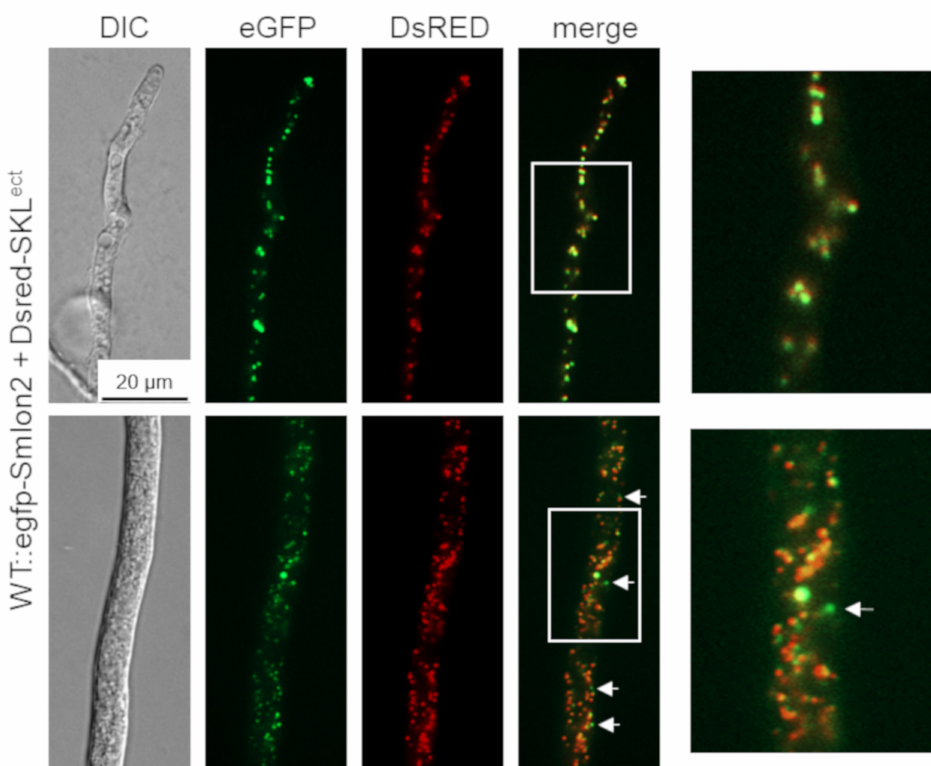
Figure 2. Co-localization of SmLON2 and the glyoxysomal reporter protein DsRED-SKL. Fluorescence microscopy was performed with the S. macrospora WT strain expressing eGFP-SmLON2 and the glyoxysomal reporter protein DsRED- SKL (WT::egfp-Smlon2 + Dsred-SKL ect ). The upper panel shows a hyphal tip and the lower panel a subapical hyphal compartment. Arrows point to SmLON2 structures not co-localizing with glyoxysomes. Scale bar is indicated. DIC, differential interference contrast. Detail 4-fold enlargements of the merge picture are indicated with a frame and shown at the right margin.